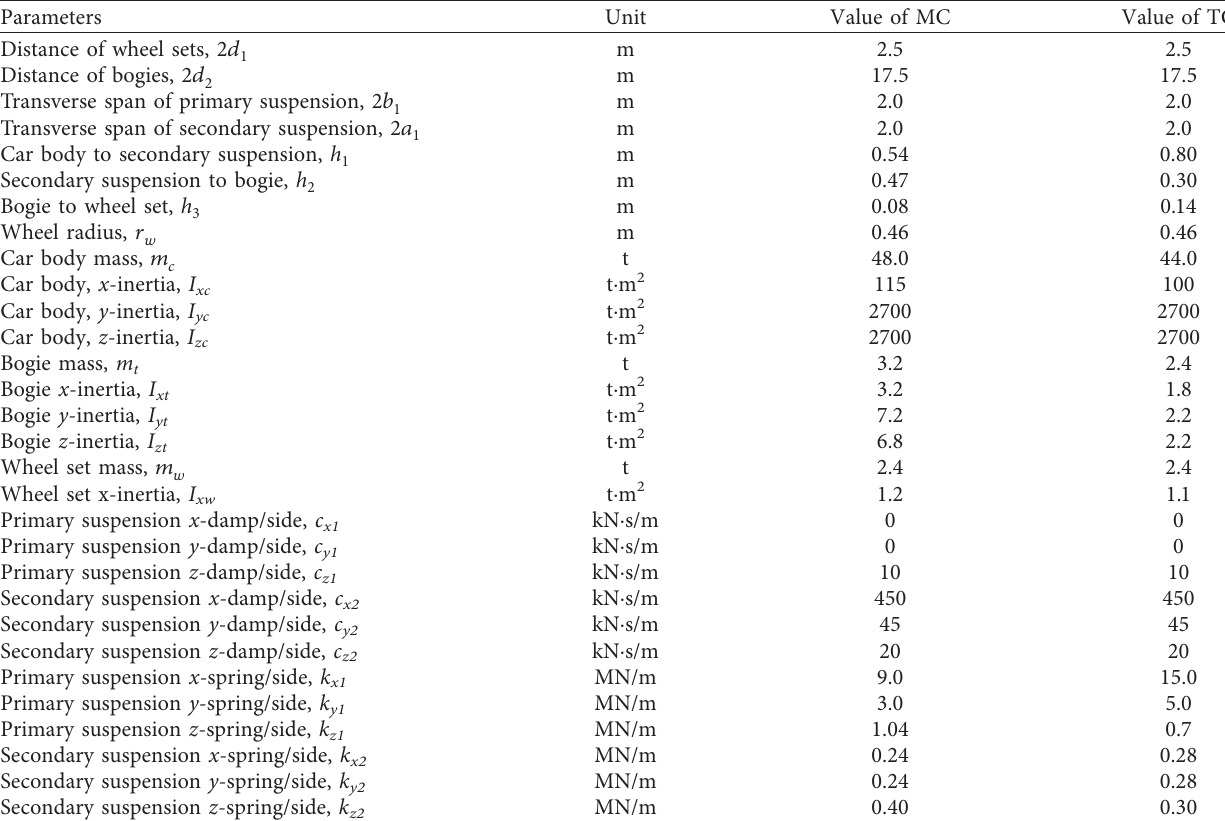
Table 1: Main parameters of vehicles used in the case